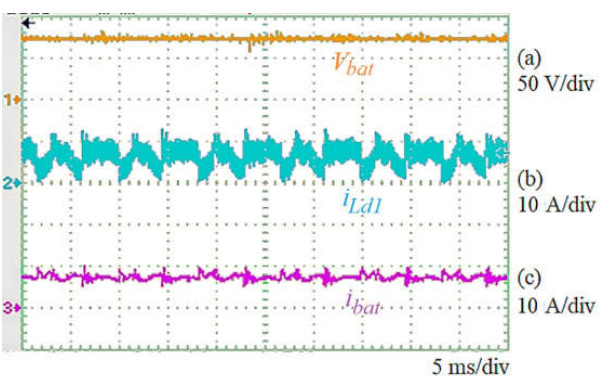
Figure 17. Experimental results for the proposed DIBC with the function of DAF: ( a ) voltage of the battery set; ( b ) inductor L d 1 current; ( c ) charging current of the battery set.